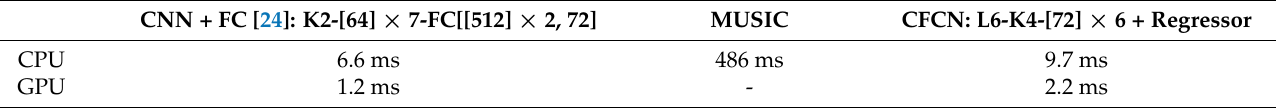
Table 2. Comparison of different model average computing